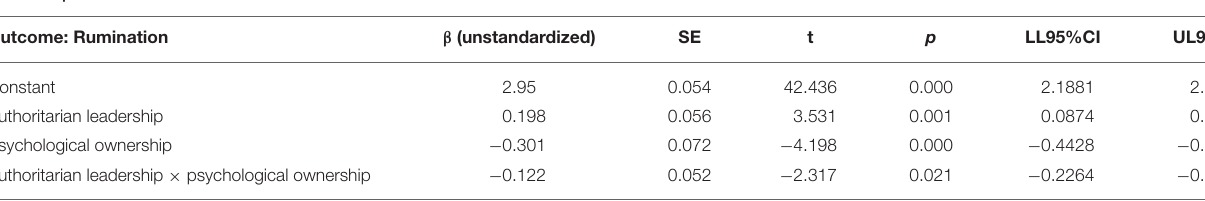
TABLE 4 | Moderation